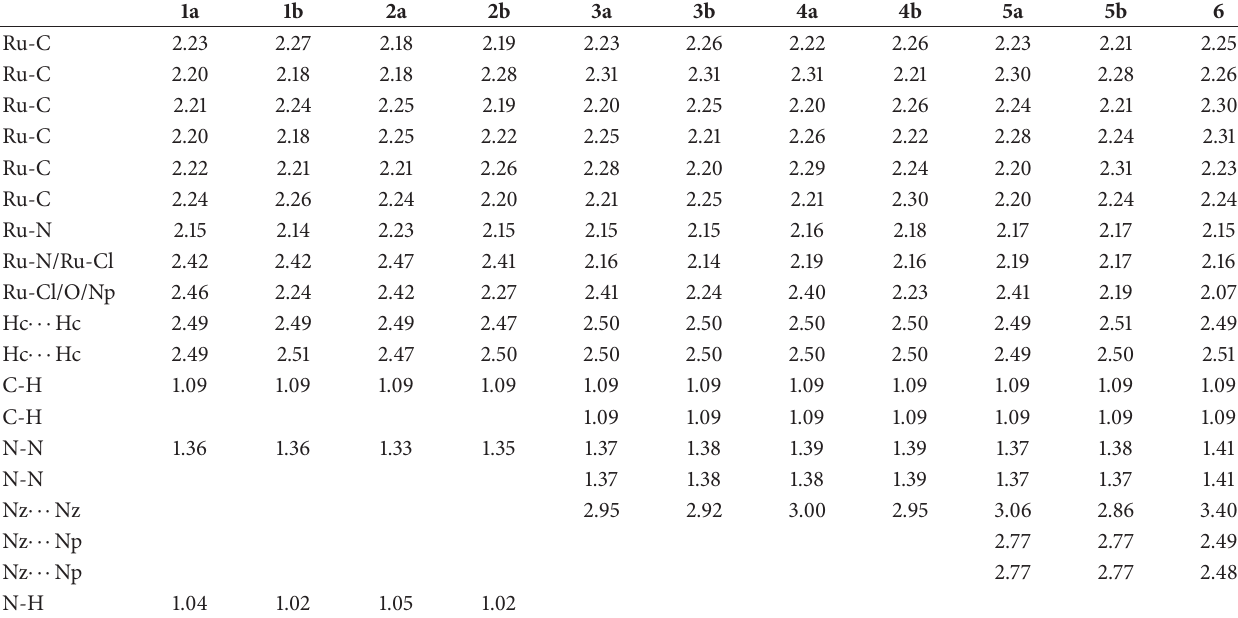
Table 1: Selected interatomic bond distances of interest in Angstroms.